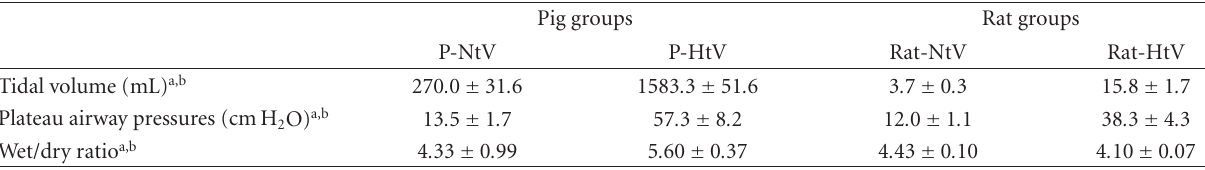
Table 2: Respiratory parameters and wet/dry weight ratio.